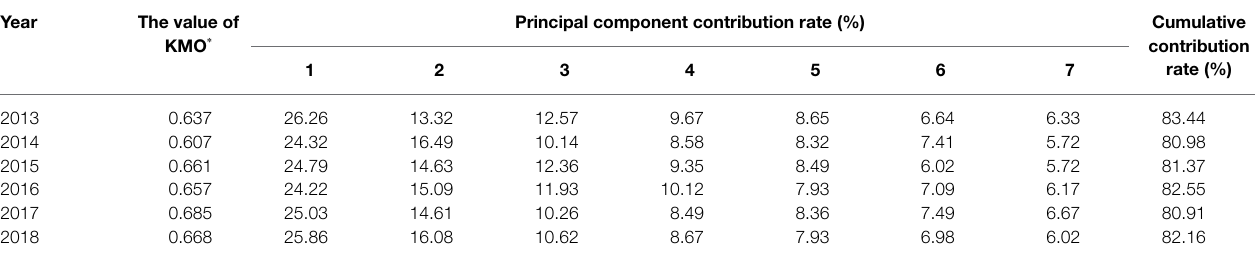
TABLE 2 | The weight of each principal component after principal component